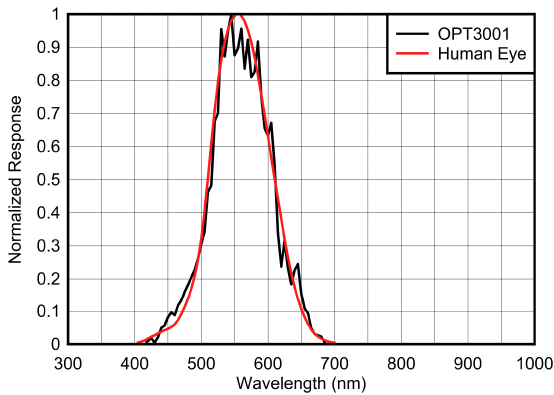
Figure 3. Spectral sensitivity of the OPT3001 sensor source: [63].